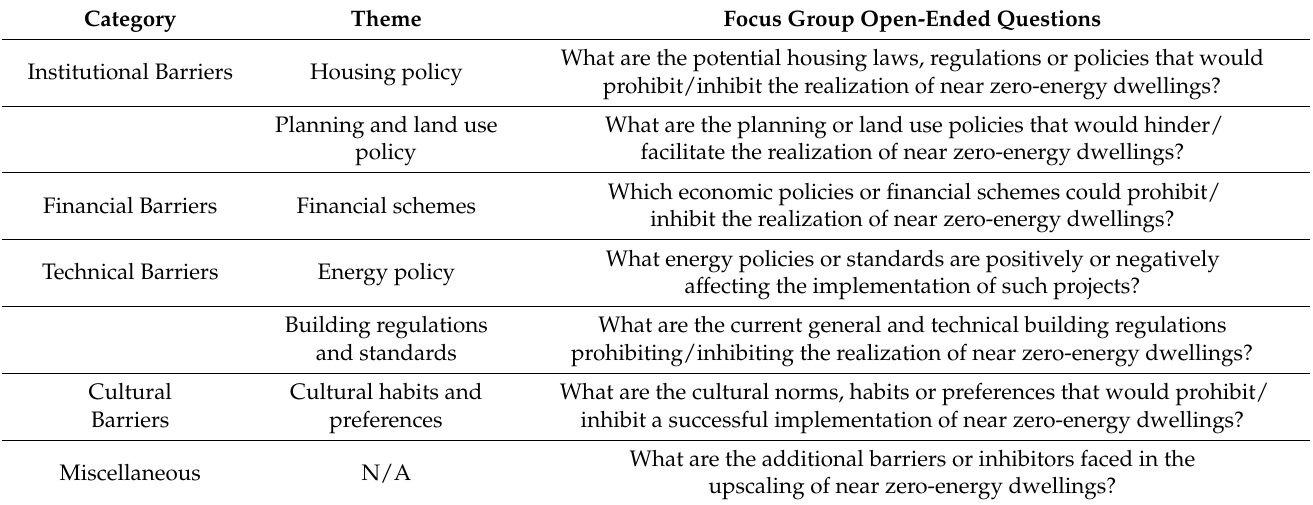
Table 4. Focus group guiding